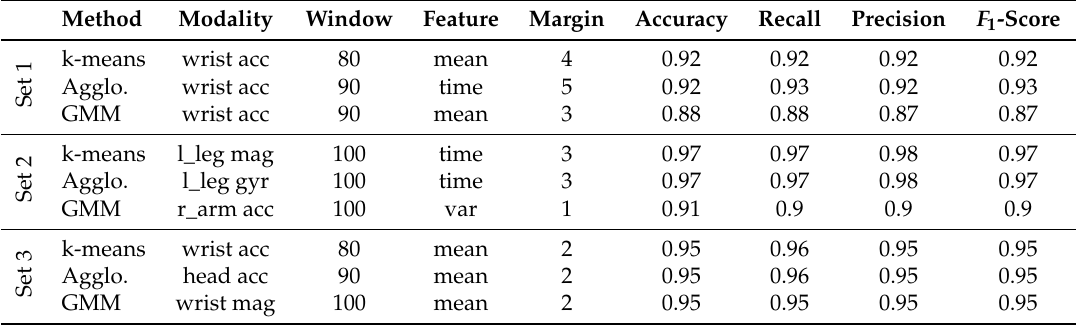
Table 1. Results for individual top experiment runs (by recall), per dataset for unsupervised methods (the feature extraction window is the number of samples (@50Hz); the extracted feature is the mean, variance or time (time = mean/var/range/median); the transition scoring margin is the number of samples) (datasets numbered as listed in Section